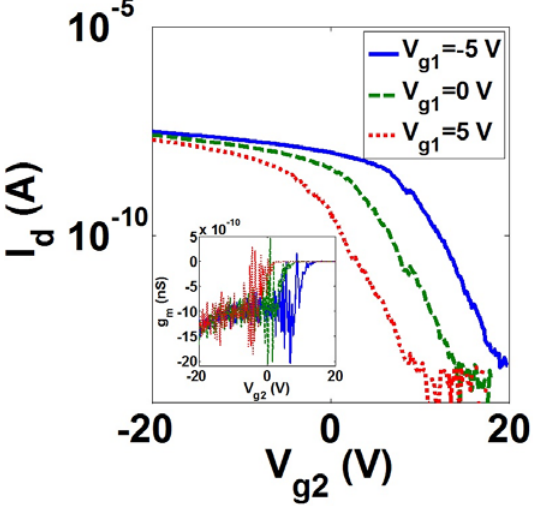
1.5 μm-length in-plane resonant nano-electro-mechanical (IP R-NEM) sensor at = 50 V d